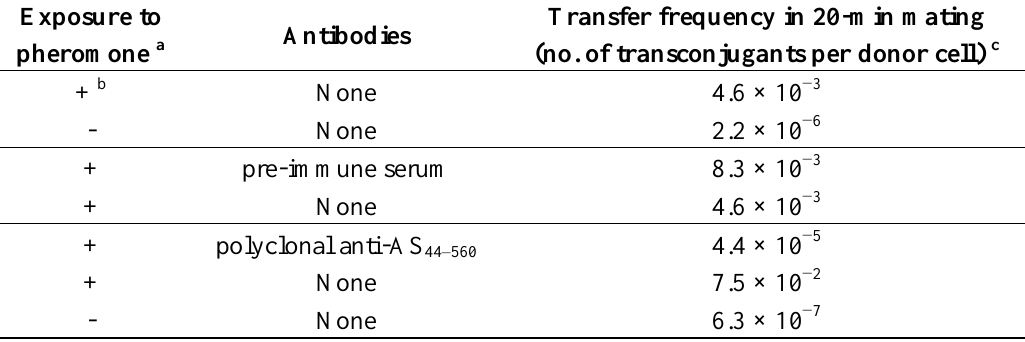
Table 1. Interference in the transfer frequencies of plasmid encoding high-level bacitracin resistance of the donor E. faecalis strain 543 to the recipient strain E. faecalis JH2-2 tested by pheromone-responsive mating experiments with or without addition of